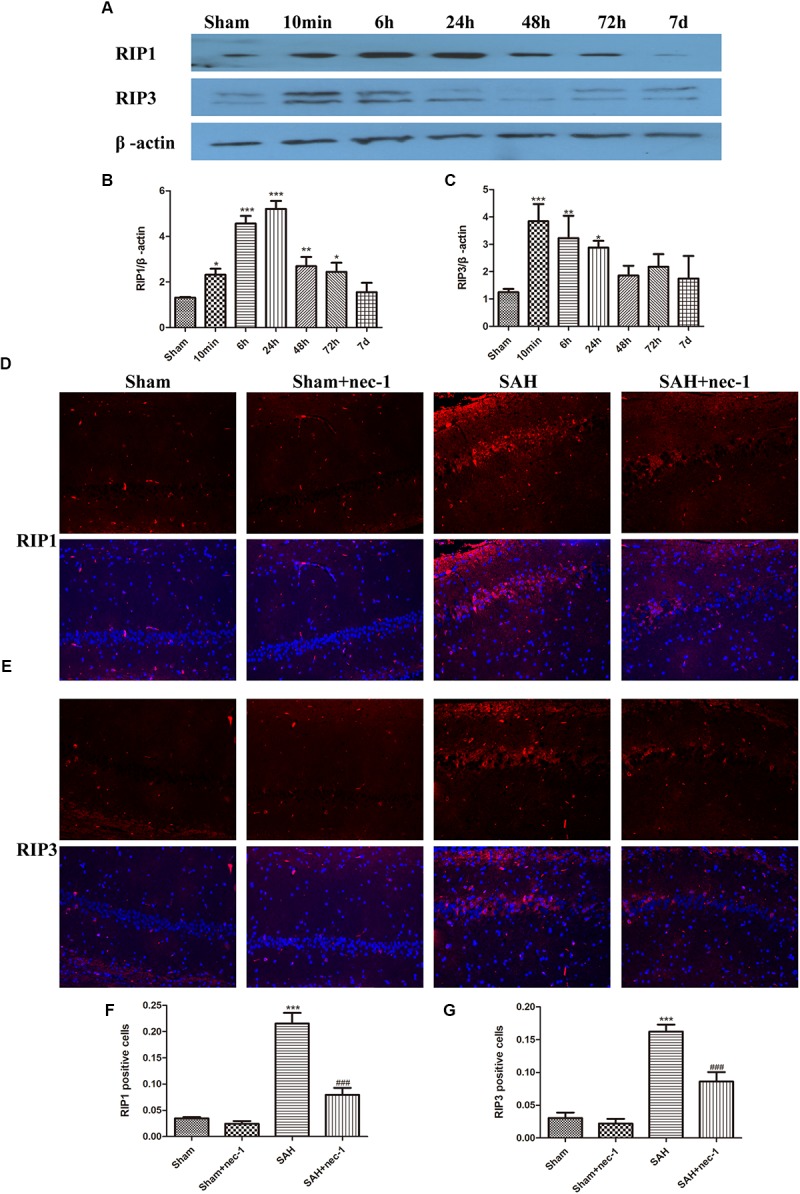
Necroptosis of hippocampal cells at different times post-SAH. (A–C) Western blotting results showed that the protein level of RIP1 increased 6 h after SAH and peaked at 24 h then decreased again. RIP3 also increased in 6 h after SAH and then decreased. Bar graphs showing the quantification of the protein levels of RIP1 and RIP3, and RIP1&3 were generated by Image-Pro Plus 6.0. The results are expressed as the RIP1&3/β-actin ratio (n = 3). The values represent the mean ± SD. ∗P < 0.05, ∗∗P < 0.01, ∗∗∗P < 0.001, SAH vs. Sham. (D–G) Immunofluorescence staining was used to detect RIP1 and RIP3. Three representative pictures were chosen in the CA1 area of hippocampus. Scale bar = 50 μm. Compared with the Sham group, RIP1 and RIP3 were significantly improved in the SAH group, and nec-1 treatment could reduce the expression of RIP1&3. The bar graphs showing the quantification of RIP1 or RIP3 positive cells (n = 4). Scale bar = 20 μm. ∗∗∗P < 0.001, SAH vs. Sham. ###P < 0.001, SAH+nec-1 vs. SAH.